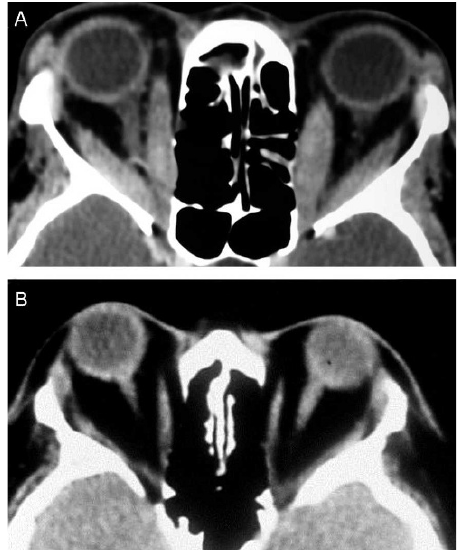
Figure 1 - Coronal CT scans from two patients with Graves’ orbitopathy. A) Patient with symmetric enlargement of the extraocular muscles in both orbits. B) Patient with asymmetric involvement of the extraocular muscles.